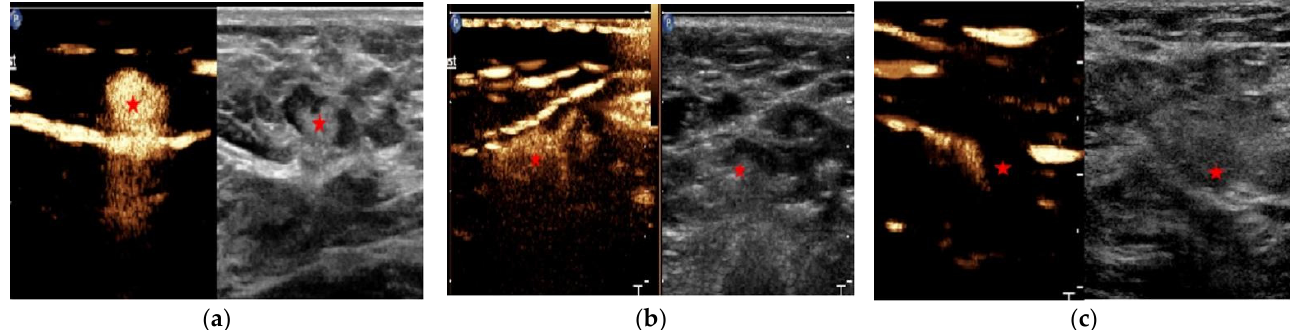
Figure 2. The enhancement patterns of sentinel lymph nodes. The asterisk represents the sentinel lymph node: ( a ) Homo- geneous enhancement; ( b ) Inhomogeneous enhancement; ( c ) No enhancement. ( a ) Homogeneous enhancement; ( b ) Inhomogeneous enhancement; ( c ) No